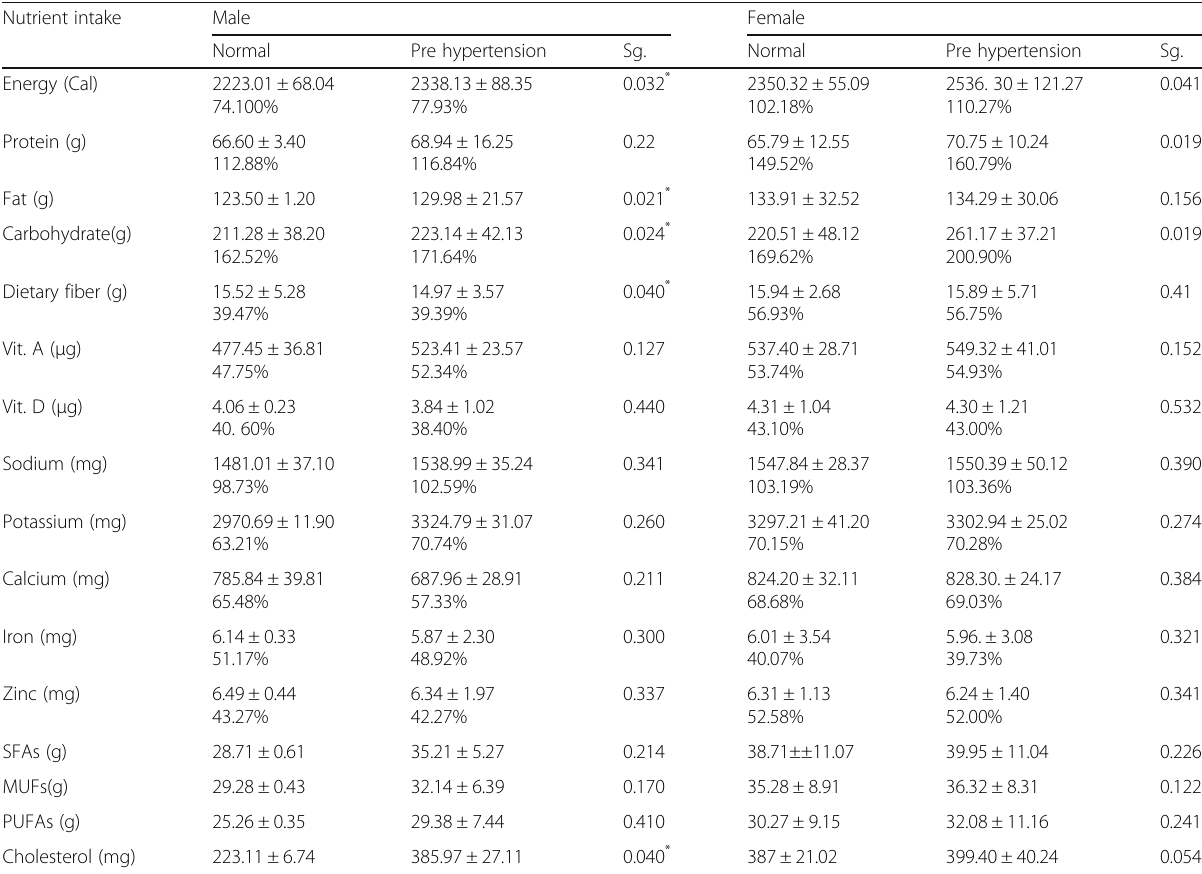
Table 4 Mean ± SD &% of RDAs & DRIs of the nutrients intake among obese adolescent under study Nutrient